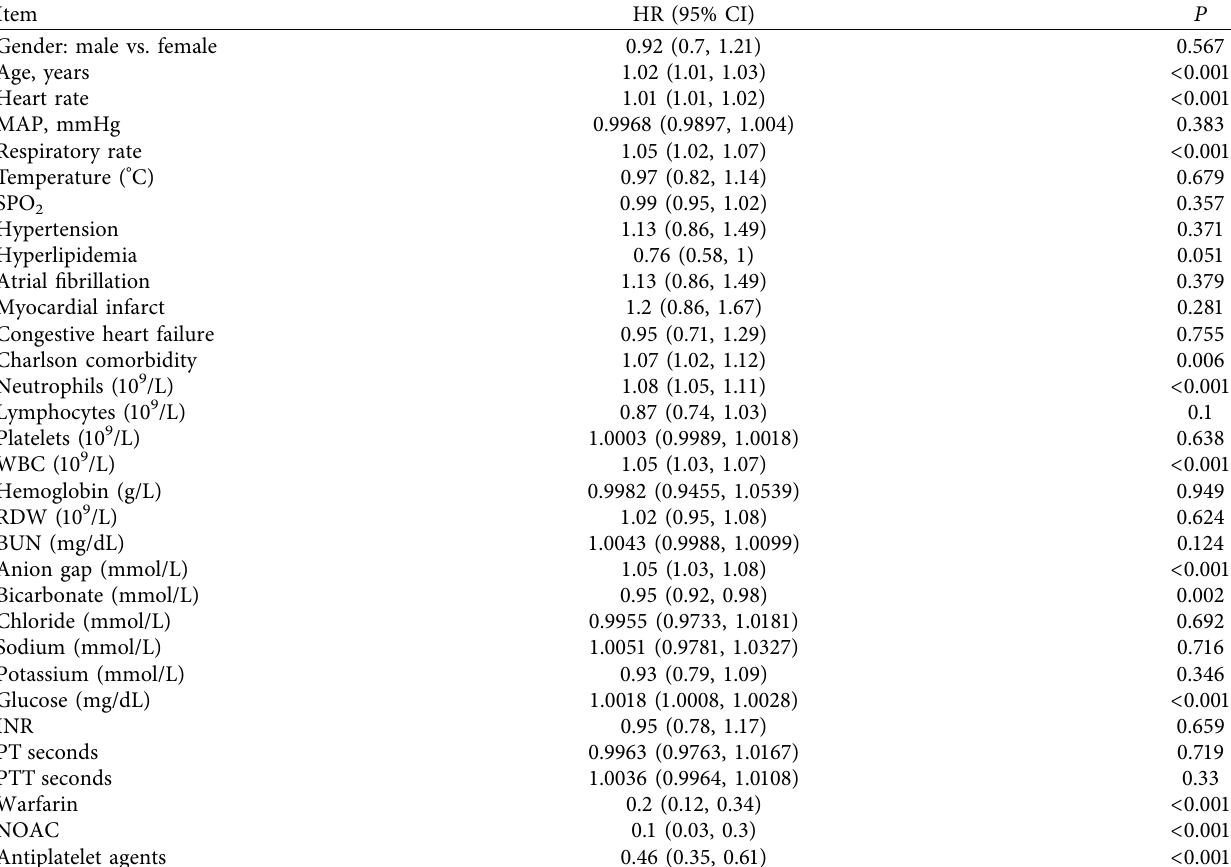
Table 2: Univariate Cox regression